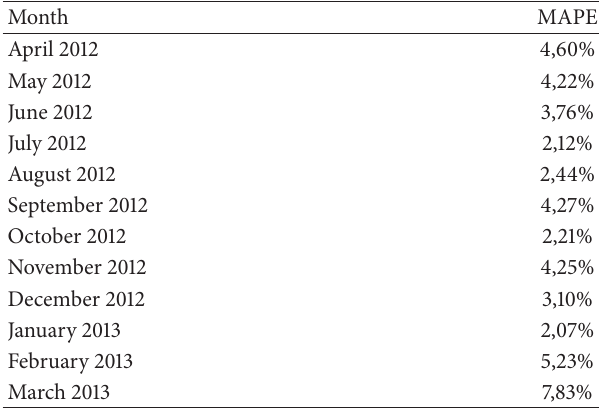
Table4:Inthefirstcolumn,wehavethemonthsofelectricitysupply of the peak contracts considered, while in the next three columns we have the mean absolute percentage errors obtained in the long-term forecasts of the contracts value during the first, second, and third month of trading, respectively.